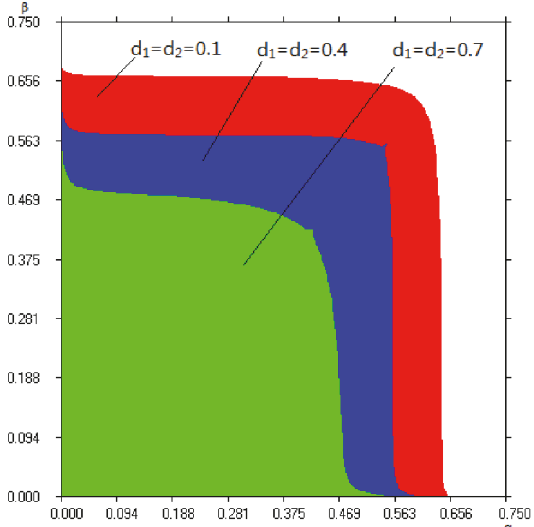
Figure 3: The stability of three values of 𝑑 1 , 𝑑 2 , with 𝛼 , and 𝛽 is changed, and 𝛾 = 0.25